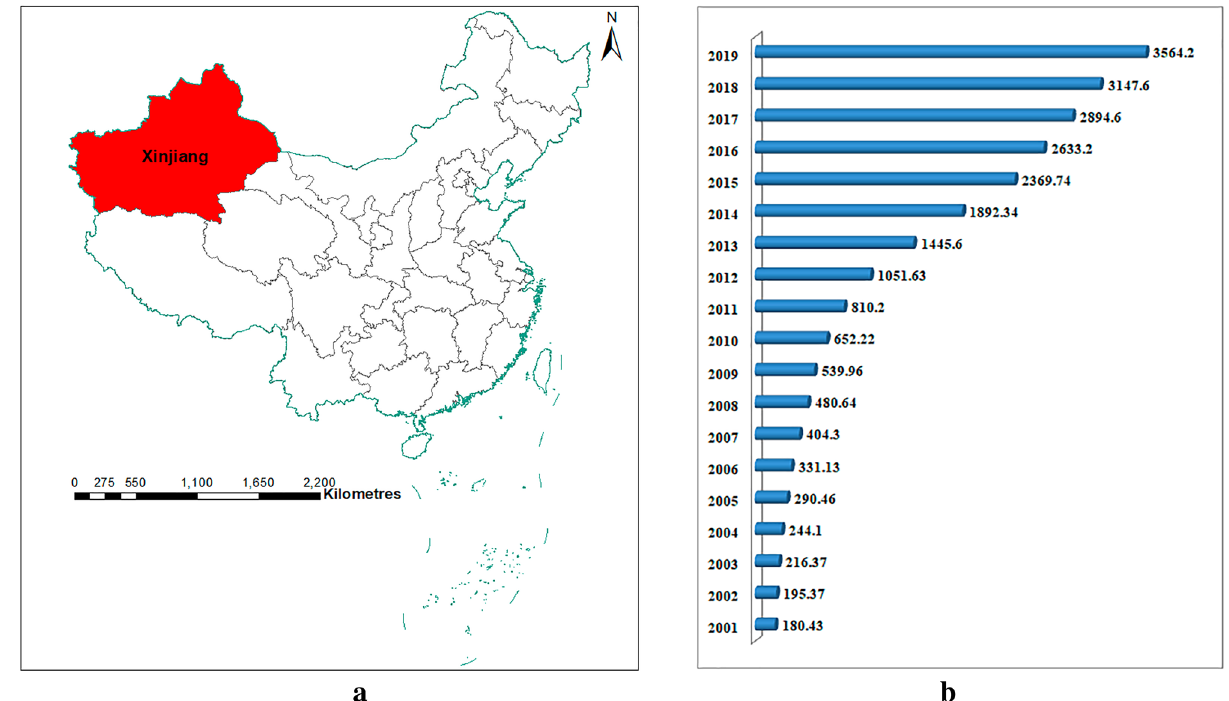
Figure 1. ( a ) The red area in the figure is the geographical location of Xinjiang, (this figure is plotted by ArcMap10.4); ( b ) Xinjiang annual electric energy production (billion